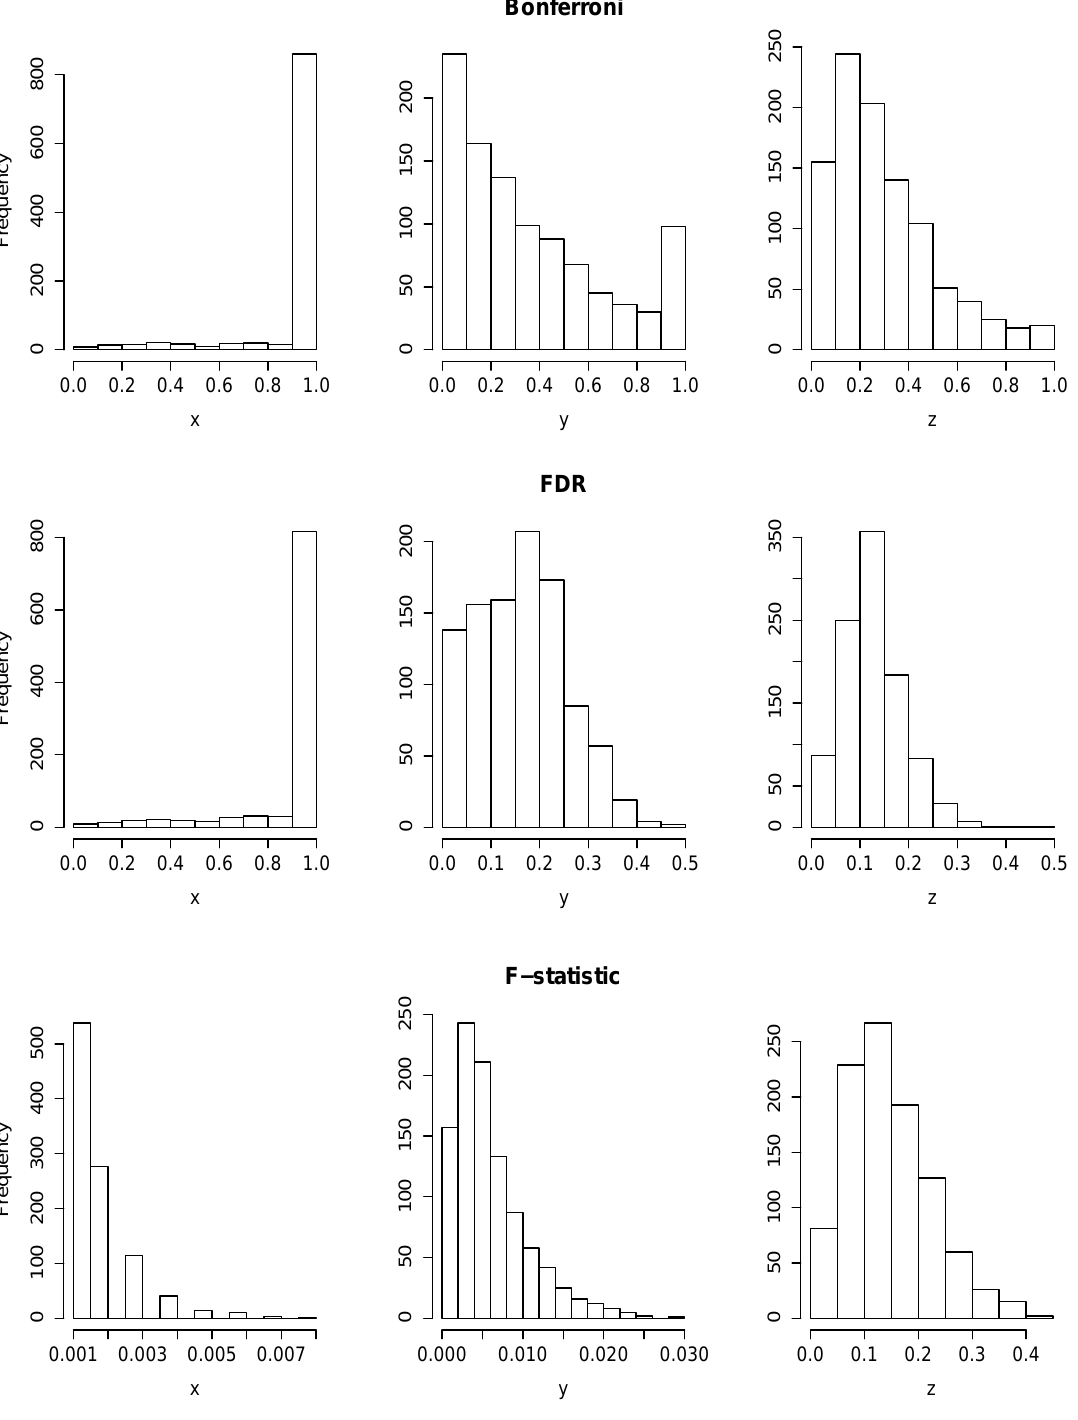
Figure 3. Histograms of 1000 p -values resulting from applying the two functional ANOVA tests based on random projections: based on the Bonferroni correction ( top row ) and on the FDR ( middle row ) and the functional ANOVA based on the F-statistic ( bottom row